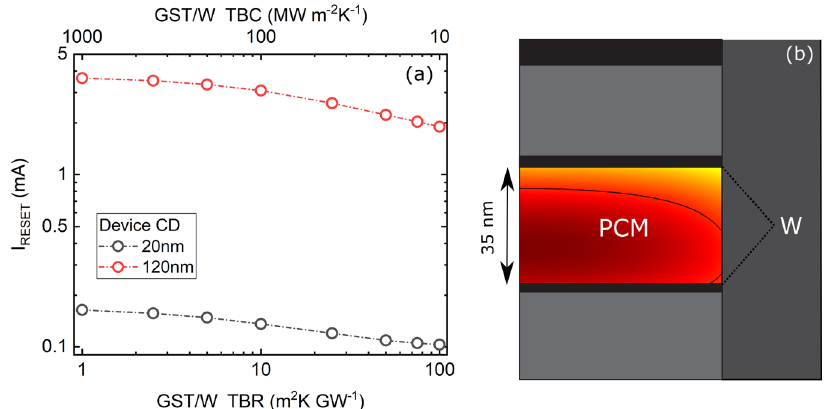
Fig. 6 The effect of thermal boundary resistance on reset current for a con fi ned memory cell geometry. a Simulation results for the reset current as a function of thermal boundary resistance (TBR) between GST and W for two different device lateral sizes. b Schematic for the PCM con fi guration and its corresponding temperature